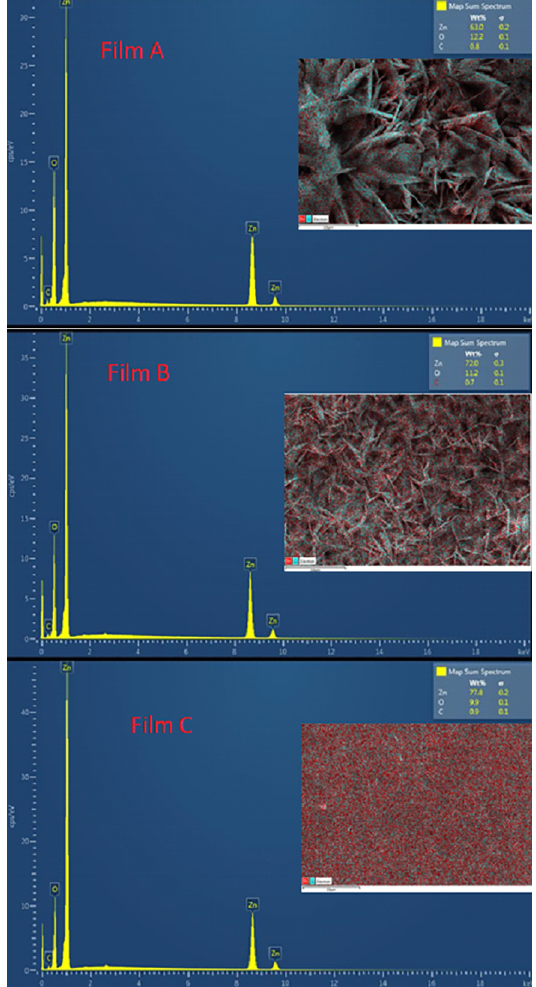
Figure 4. EDS data and spectrum for ZnO thin films A, B and C